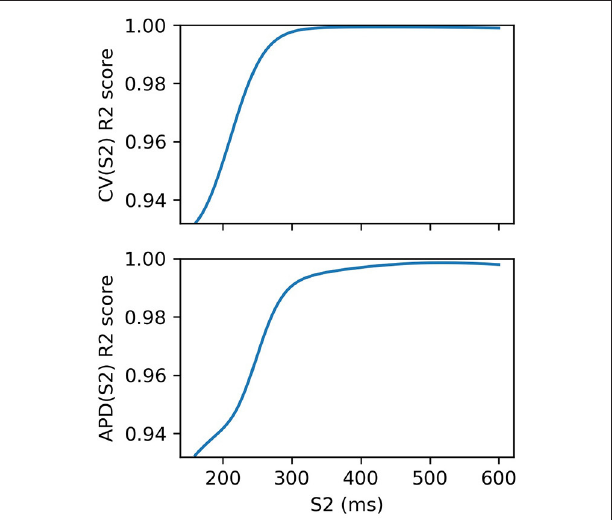
FIGURE 3 | R2 scores for S2 restitution curves from 5-fold cross-validation. Performance decreases with S2, although these validation scores include RCE prediction at S2 ERP(S1) corresponding to virtual regions of the curves ≤ where no measurements can be